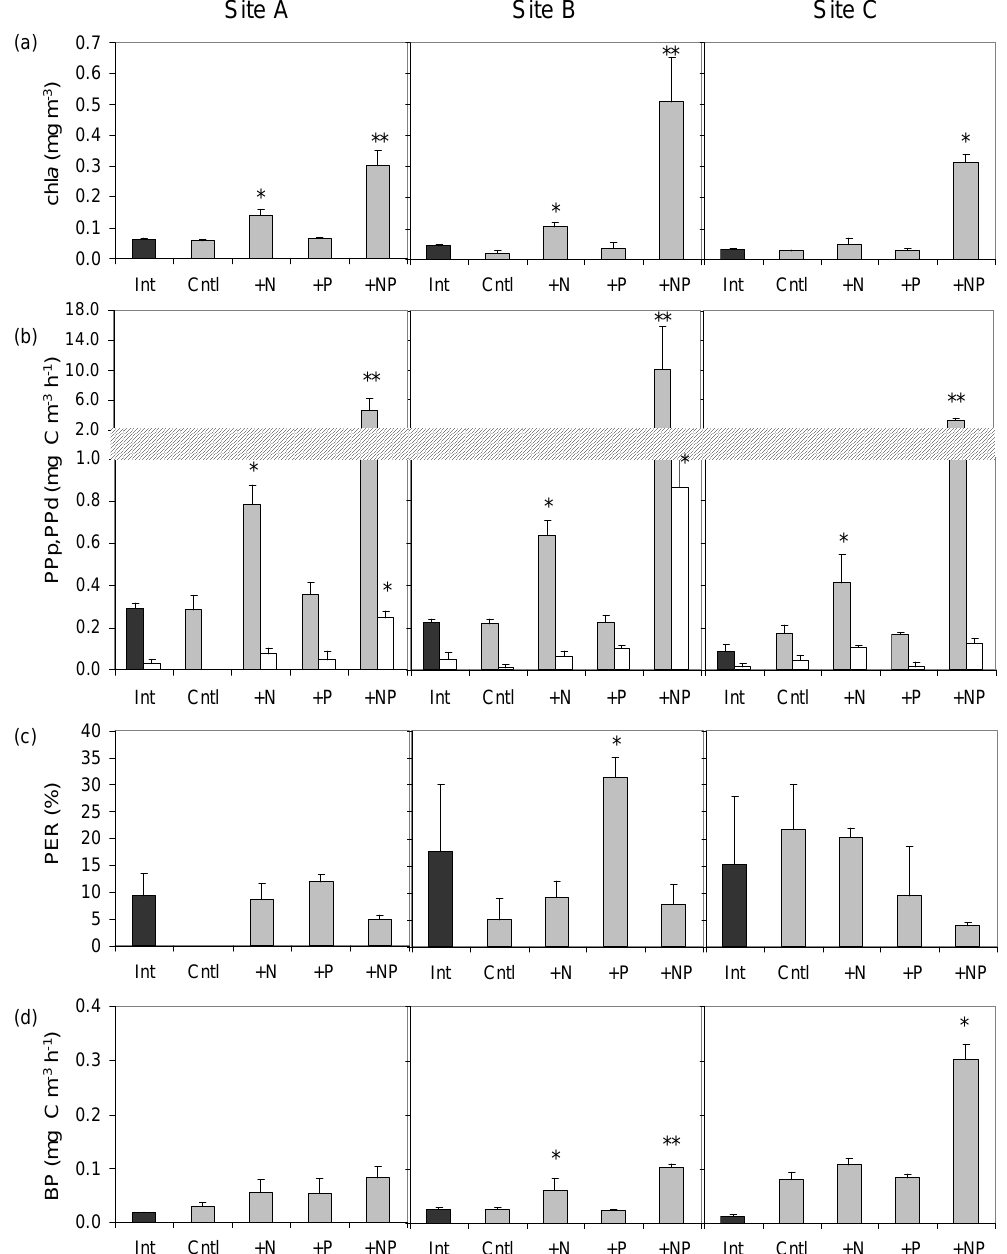
Fig. 1. Values of the parameters studied in the microcosms, at the initial conditions (Int, black bars) and at the end of the experiment, in the Control (Cntl), nitrogen (+N), phosphorus (+P), and nitrogen and phosphorus (+NP) amendments: (a) chlorophyll- a (b) particulate (grey bars) and dissolved (white bars) primary production (c) percentage extracellular release (PER) (d) bacterial production. Missing values of PPd and PER in the Control in (b) and (c) denote that measurements were below detection limit. Chl- a , PPp and BP figures are modified from Tanaka et al. (2011). * denotes significant difference with the